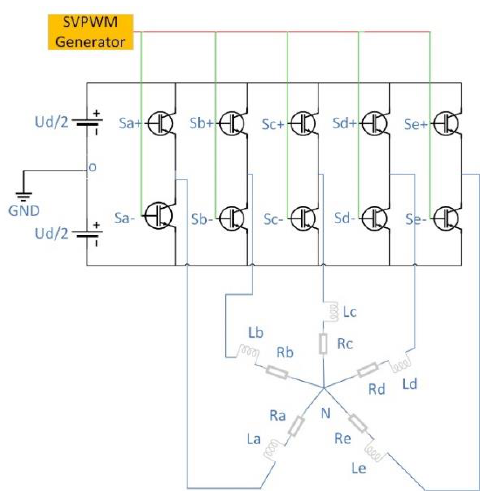
Figure 2. Five-phase voltage source inverter structural topology.